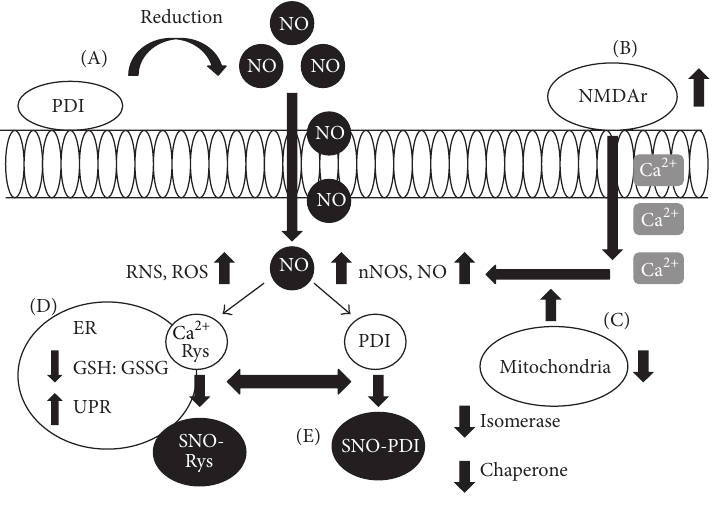
Figure 2: Cell surface PDI, NO, and SNO-PDI. (A) Cell surface PDI reduces NO from extracellular SNO proteins (SNO-P) and in the process undergoes thiol modification. (B) Hyperactivation of the NMDAr leads to an intracellular influx of Ca 2+ ions (NMDAr may also undergo reversibleS-nitrosylationtoameliorateexcessiveactivity).(C)InhibitionofmitochondriacontributestoanincreaseinintracellularNOwhich is potentially oxidized by O 2 leading to an increase in NO, nNOS, ROS, and RNS. (D) Increases in RNS/ROS alters the ER redox environment, and NO S-nitrosylates Ca 2+ ryanodine (Ryn) receptor leading to a disruption in Ca 2+ homeostasis. (E) ER-resident proteins such as PDI are vulnerable to S-nitrosylation, deactivating its isomerase and chaperone activity, leading to accumulation of misfolded proteins, ER stress, and UPR